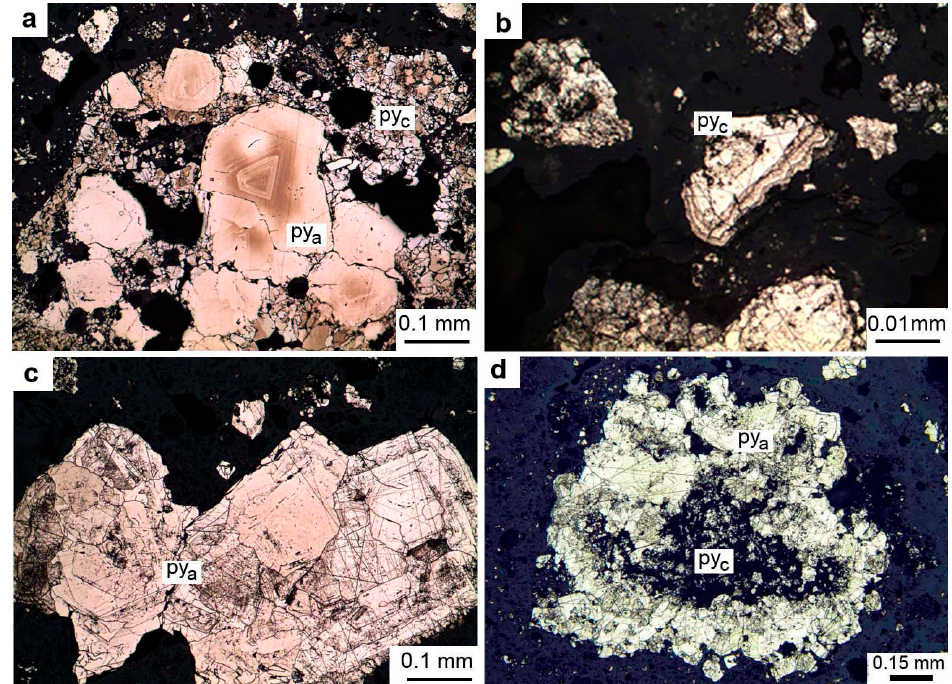
Figure 5. Clastic vs authigenic pyrite: ( a ) clast of fine ‐ grained pyrite with numerous pores filled with authigenic zoned crystalline pyrite (zoning is emphasized by different tint of surficial oxidation of polished samples); ( b ) clast of zoned pyrite aggregate; ( c ) aggregate of zoned authigenic pyrite crystals; ( d ) pyrite nodule with central porous domain and polycrystalline outer rim. Reflected light. Photomicrographs ( b – d ), etched by HNO 3 .